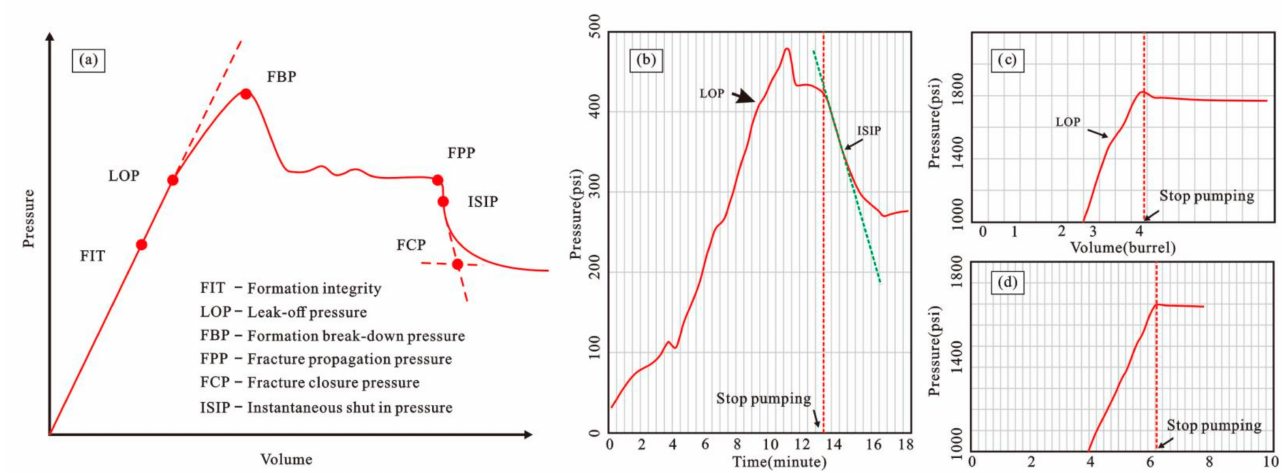
Figure 5. ( a ) Classic XLOT curve in the drilling [24]; ( b – d ) The different types XLOT curves in study